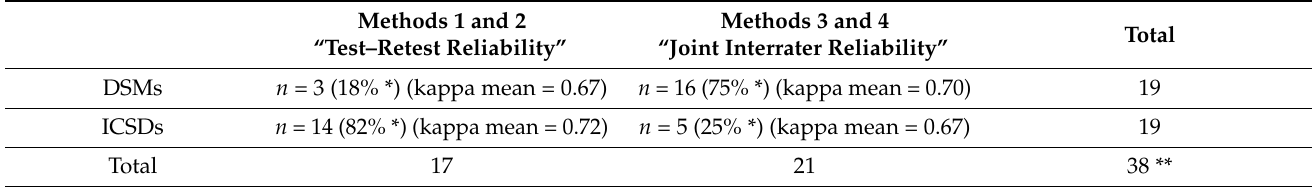
Table 1. Comparisons of reliability methods and subtypes of classifications. n represents the number of Cohen’s kappa coefficients identified for main sleep–wake disorders in the 15 studies